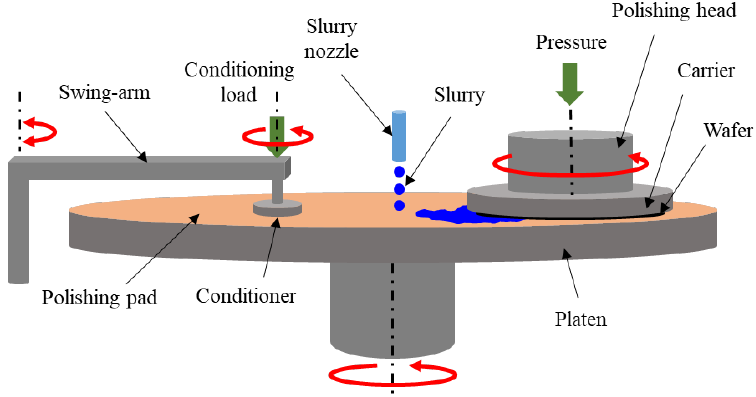
Figure 1. Schematic illustration of chemical–mechanical polishing (CMP) and swing-arm condi- tioning system.